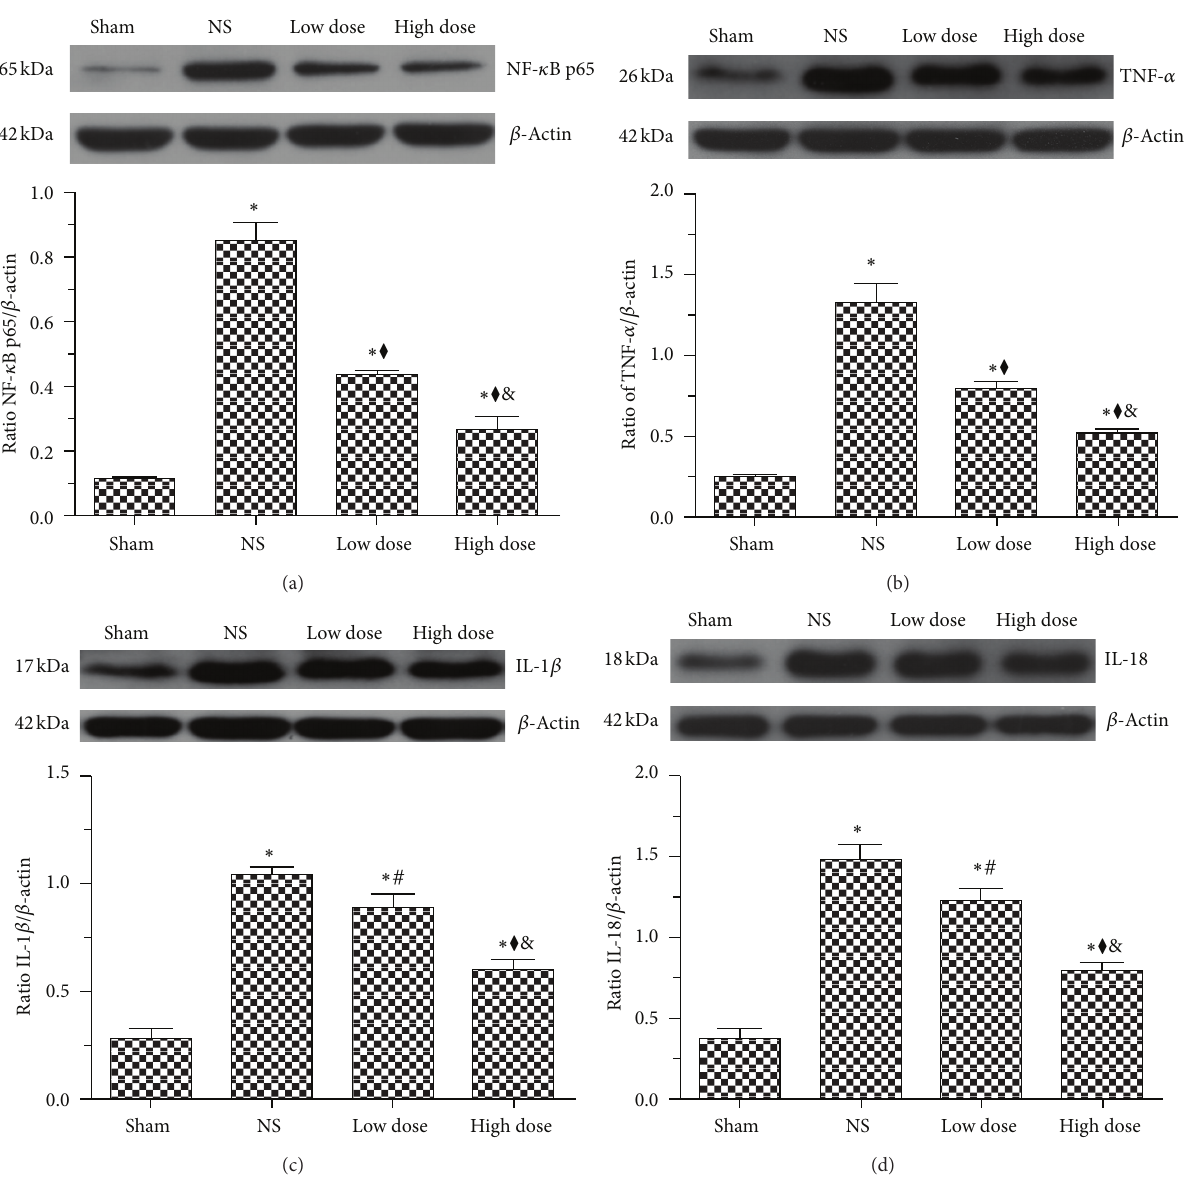
Figure 4: Scutellarin attenuates hypertension-induced brain expression of NF- 𝜅 B, TNF- 𝛼 , IL-1 𝛽 , and IL-18. Western immunoblot analysis for (a) NF- 𝜅 B p65, (b) TNF- 𝛼 , (c) IL-1 𝛽 , and (d) IL-18 in the rat cortex and striatum. Treatment with scutellarin significantly reduced the expression of these inflammatory markers in a dose-dependent manner. ∗ 𝑃 < 0.001 versus sham group; # 𝑃 < 0.05 , ⧫ 𝑃 < 0.001 versus NS group; & 𝑃 < 0.001 versus low-dose